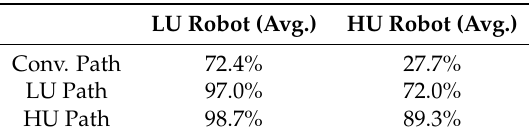
Table 3. The quality of